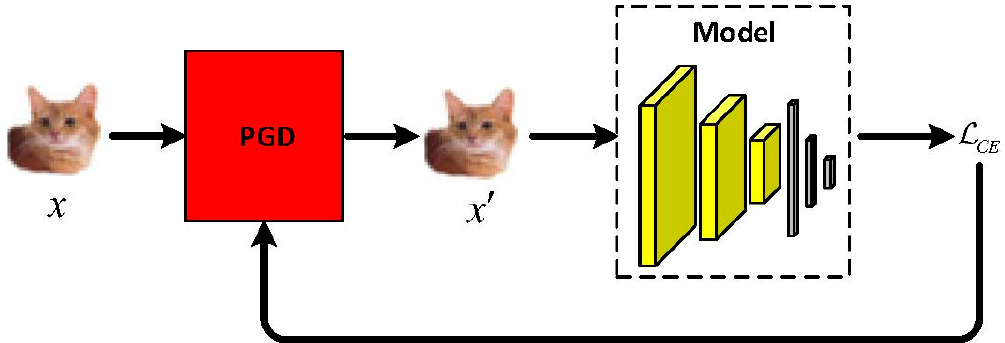
Figure 3. The training procedure of AT. In each training step: (1) the threat model attacks the model using PGD to generate adversarial examples; (2) the generated adversarial examples are used to train the model. This procedure is iterated until the model converges.